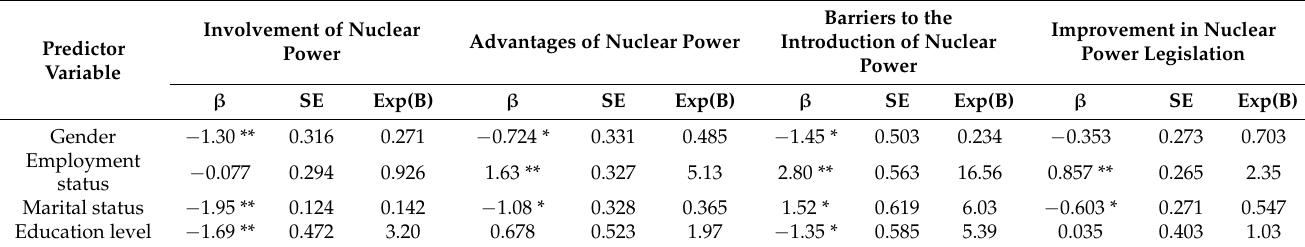
Table 3. Multivariate binary logistic regression analyses relevant to the public perception of nuclear energy. Involvement of Nuclear Predictor Variable